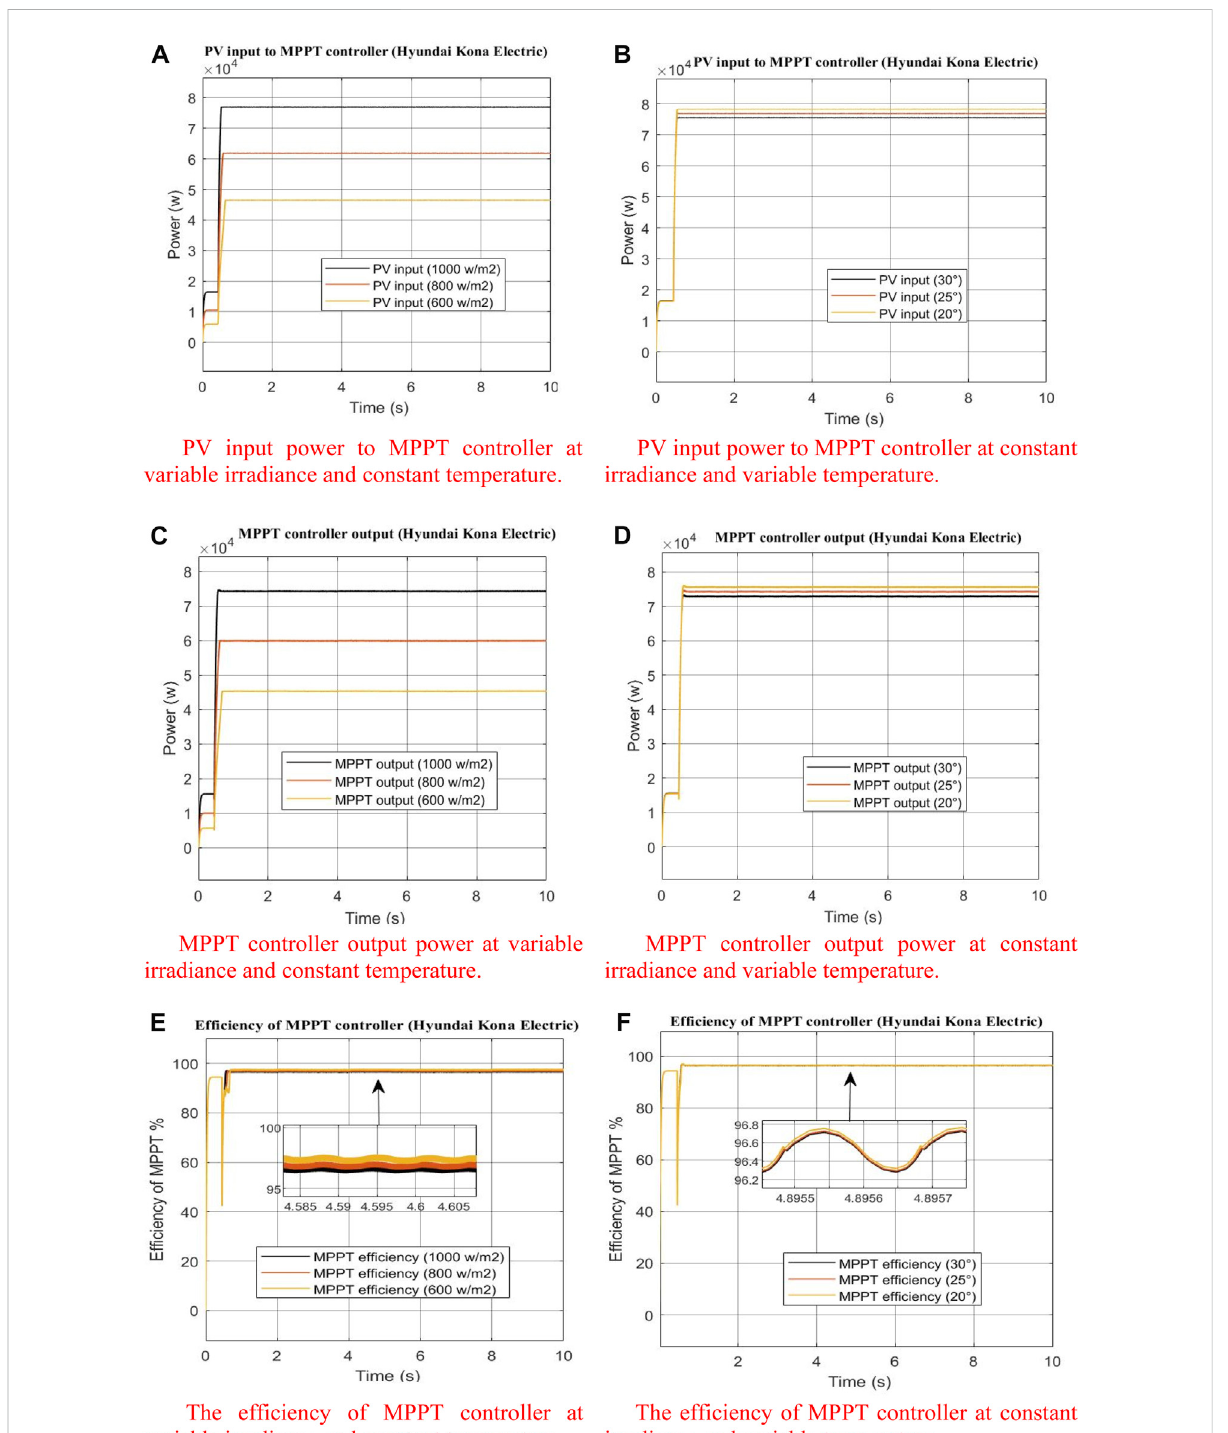
FIGURE 14 Simulation results of the MPPT controller for Mercedes EQA 250. (A) PV input power to MPPT controller at variable irradiance and constant temperature. (B) PV input power to MPPT controller at constant irradiance and variable temperature. (C) MPPT controller output power at variable irradiance and constant temperature. (D) MPPT controller output power at constant irradiance and variable temperature. (E) Ef fi ciency of the MPPT controlleratvariableirradianceandconstanttemperature. (F) Ef fi